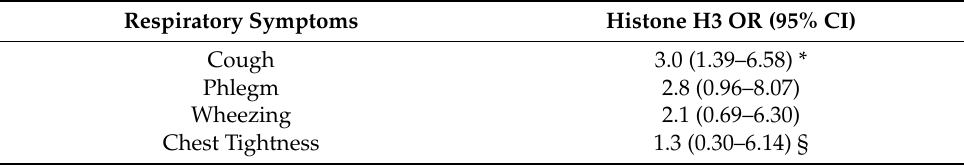
Table 4. Associations between reported respiratory symptoms and histone H3